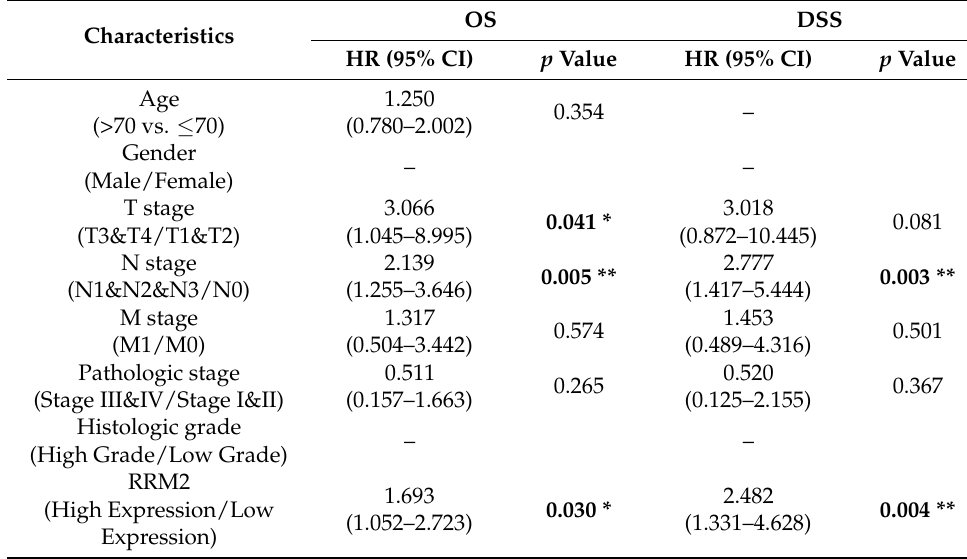
Table 2. Multivariable Cox regression of RRM2 and clinical features of BLCA in